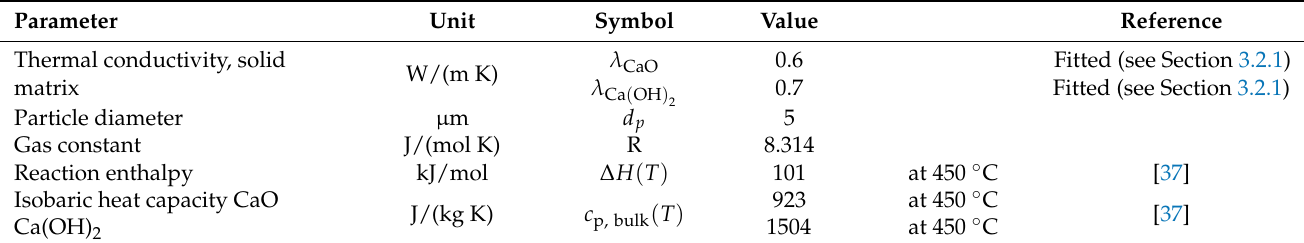
Table 3. Overview of the used parameters for the numerical